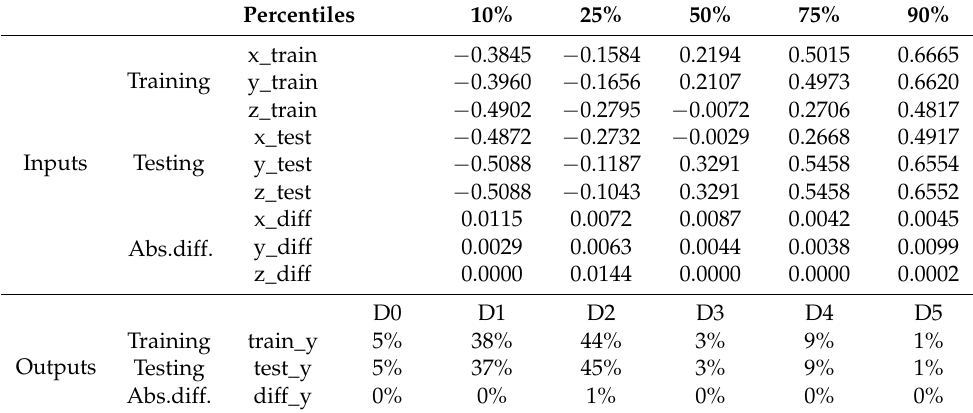
Table 6. Training and Testing dataset similarity for NW (3D).